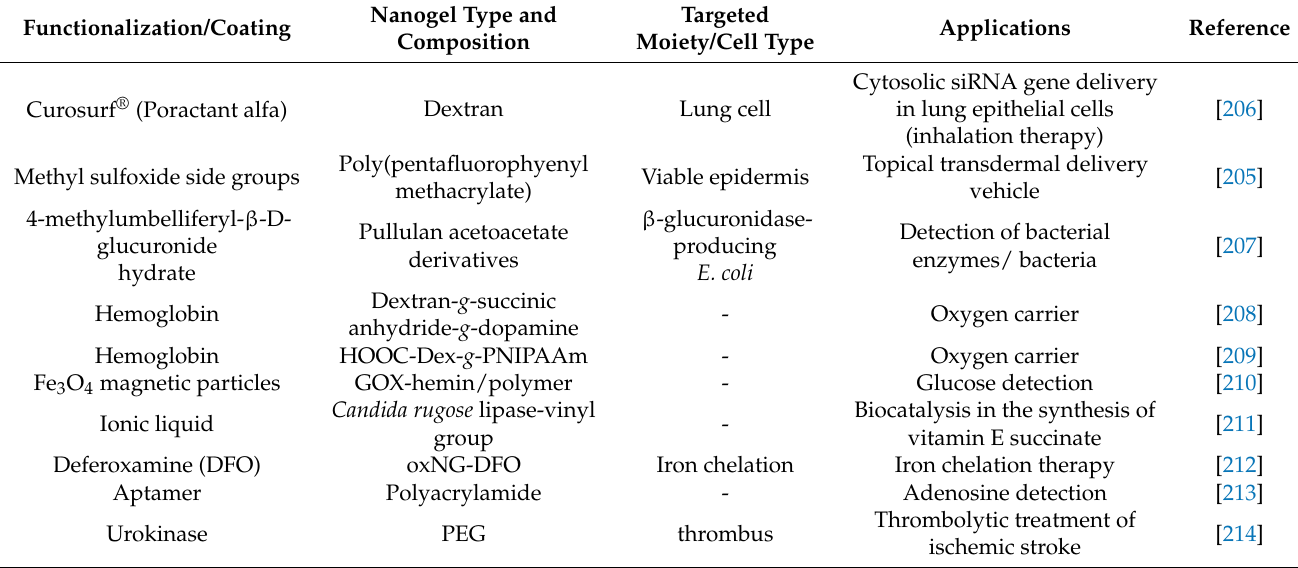
Table 6. Functionalized NGs-based approaches in other